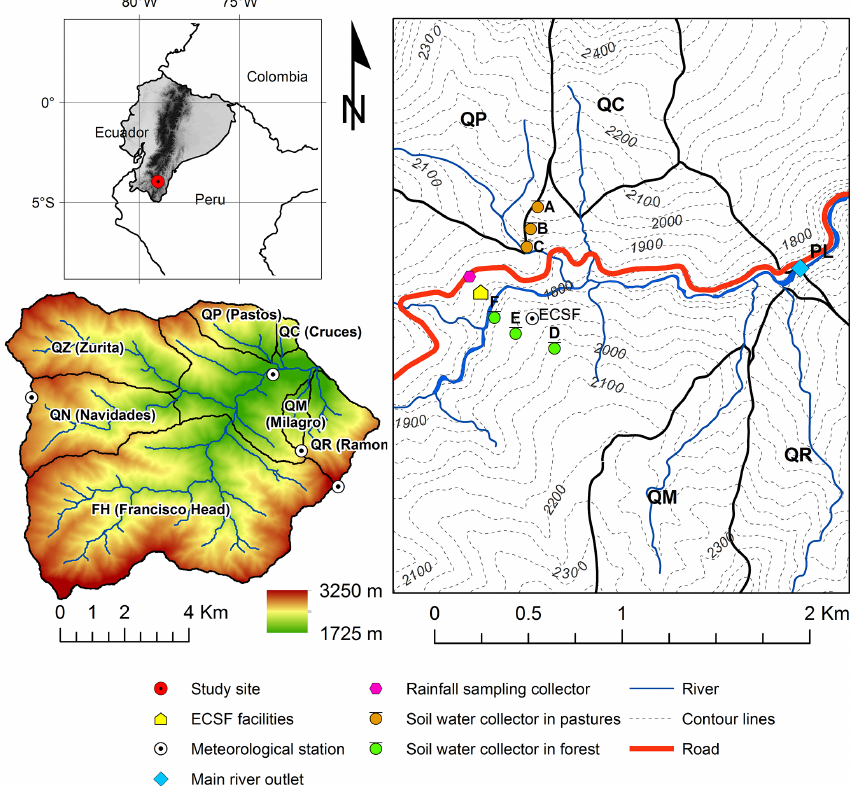
Figure 1. San Francisco catchment with sampling locations and delineation of corresponding drainage area. Names and acronyms are shown in bold. Framed image shows the zoomed area of the lower part of the